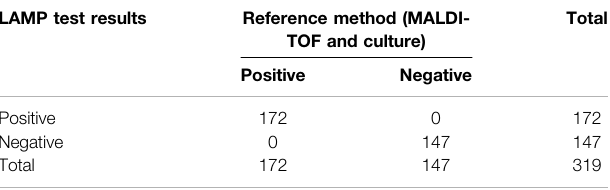
TABLE 5 | Contingency table for K. pneumoniae – speci fi c